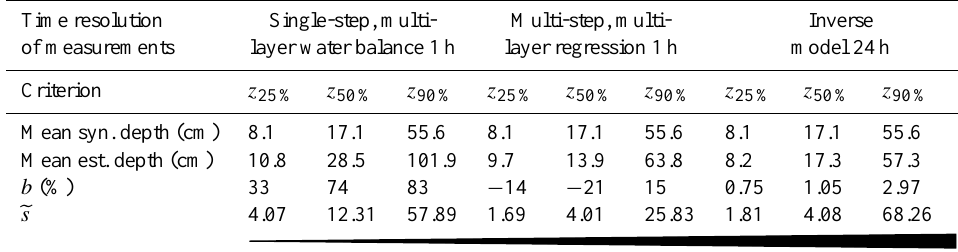
estimated (est.) depth describe the mean depth over 33 days, where water extraction occurs. b is the 885